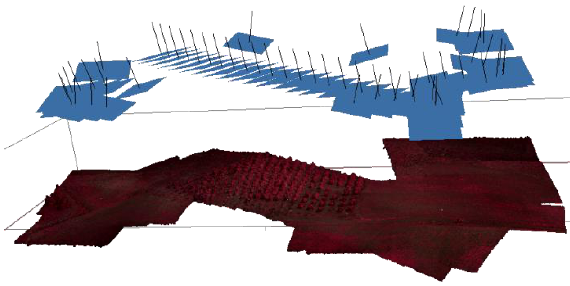
Figure 2b. Generated Tiff image (NIR / R / G)